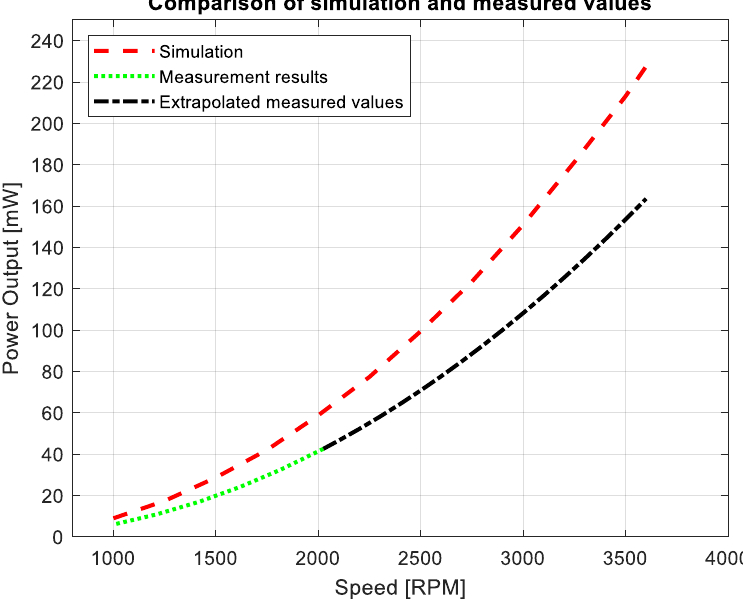
Figure 6. Power Output test, measurement and simulation results, 0–3600 rpm, load 15 Ω .